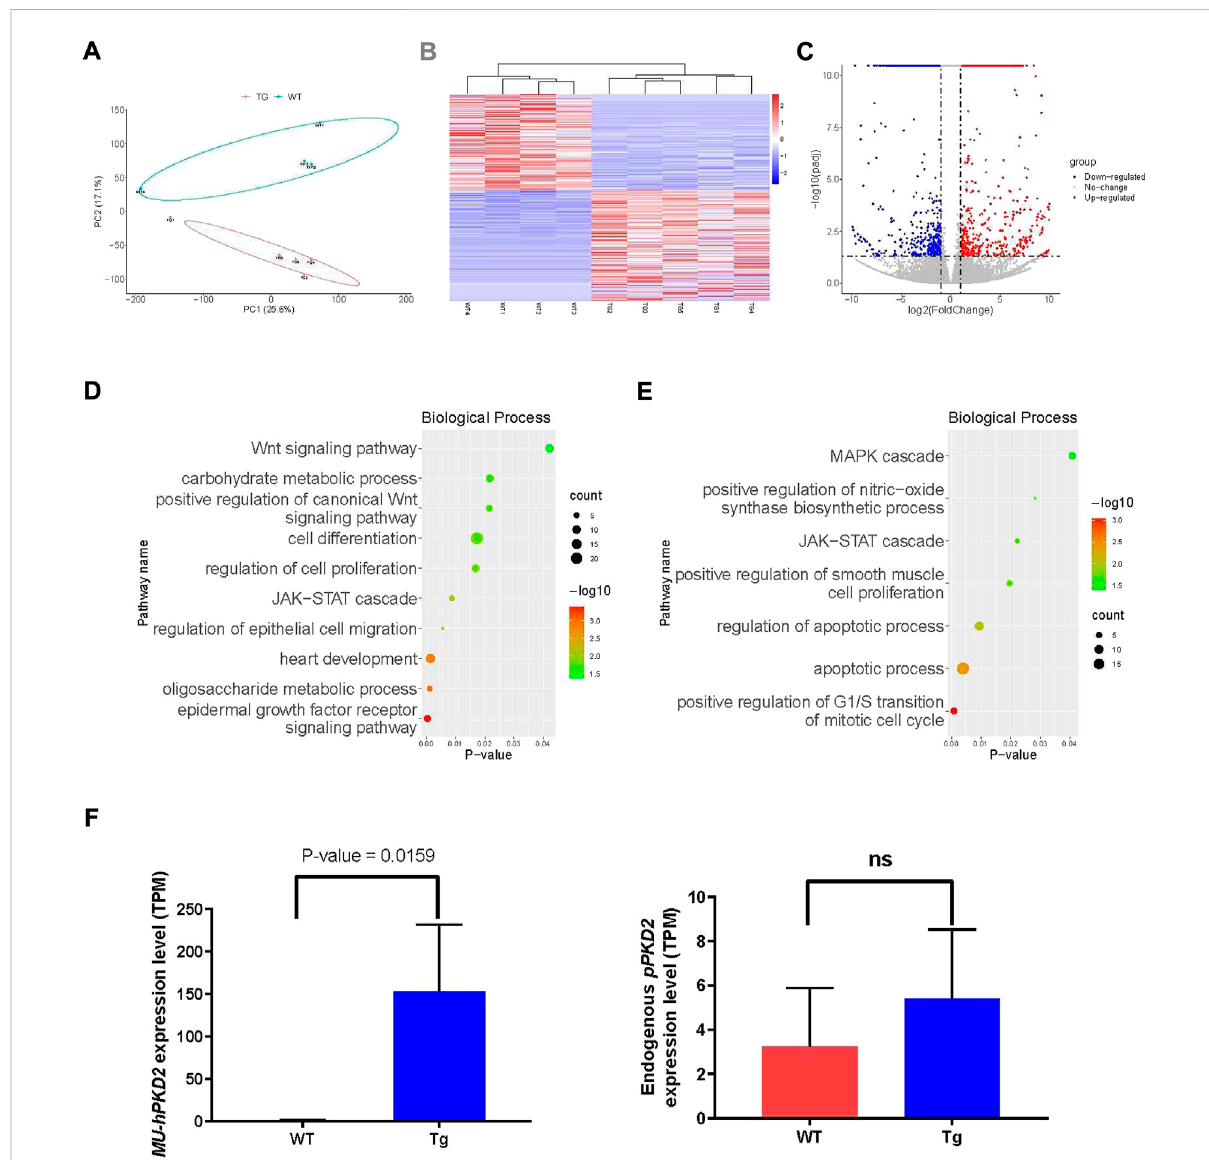
FIGURE 4 RNA-seq analysis of pigkidneys. (A) Principalcomponentanalysis(PCA) ofmergedRNA-seqdata indicated theseparation ofthe hPKD2-D511V group(MU-hPKD2-01-05)andtheWTgroup(WT-hPKD2-01-04). (B) TheHeatmapofRNA-seqdatawiththe hPKD2-D511V group(MU-hPKD2-01- 05)ortheWTgroupbasedontheLog 2 intensity. (C) Volcanoplotsshowingtheadjusted p -valuesandthelog 2 foldchange(FC)valuesofgenesinthe hPKD2-D511V group (MU-hPKD2-01-05) versus the WT group (WT-hPKD2-01-04). DEGs are indicated by the red or blue dots. (D,E) Bubble plotsofsigni fi cantgeneontology(GO)(biologicalprocesses)termsenrichedingenesfromtheDEGsets(upregulatedDEGforDanddownregulated DEG for E) of the two genotypes. (F) The TPM of hPKD2 and pPKD2 in hPKD2-D511V group (MU-hPKD2-01-05) and WT